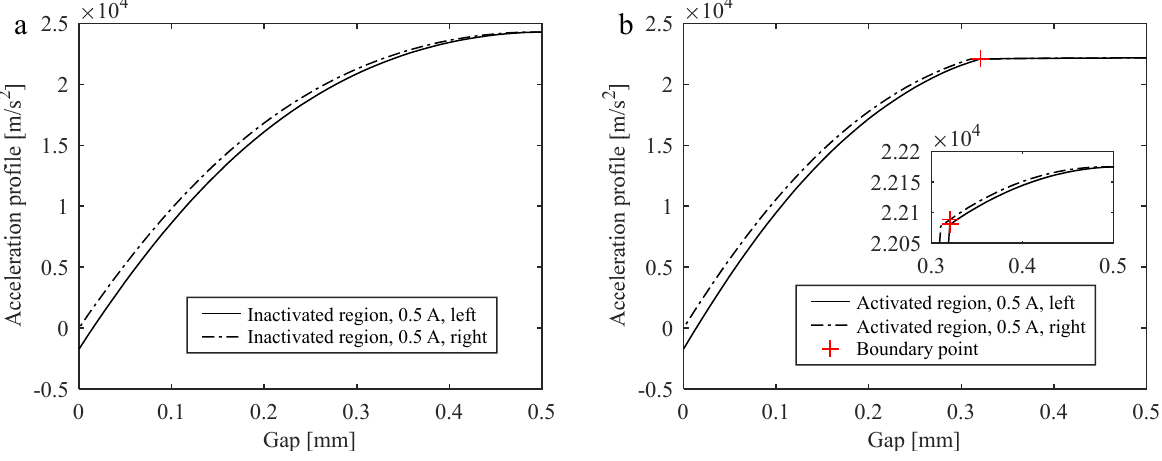
Figure 17. Asymmetry of the acceleration profiles for the excitation current of 0.5 A.